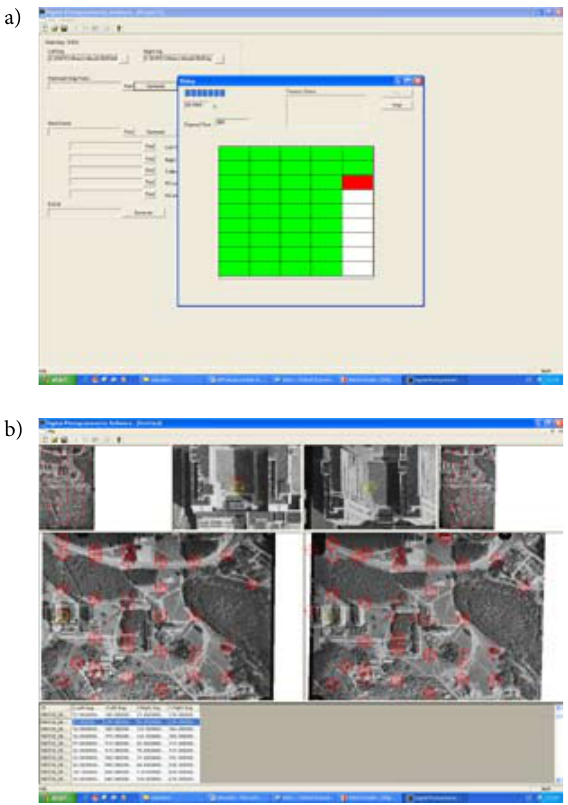
Fig 3. Image matching in DDPS: a) automatic searching homologous points, b) fragment on matching results